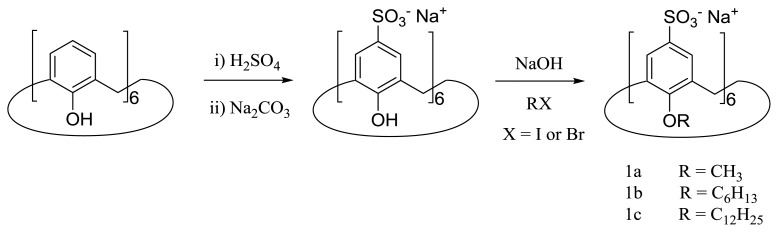
Synthesis of alkylated p-sulfonatocalix [6]arenes.